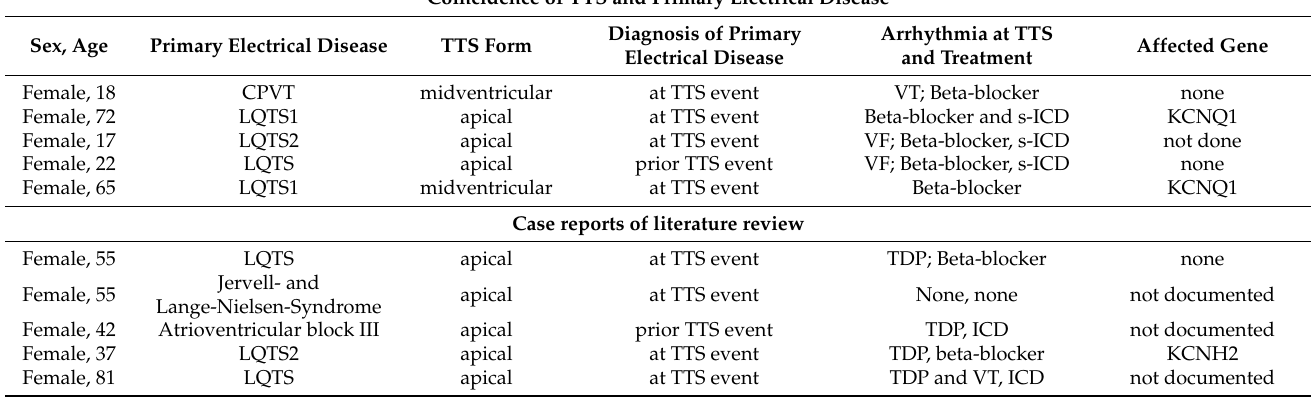
Table 1. Illustration of all TTS cases showing a presence of primary channelopathy in our cohort and in published